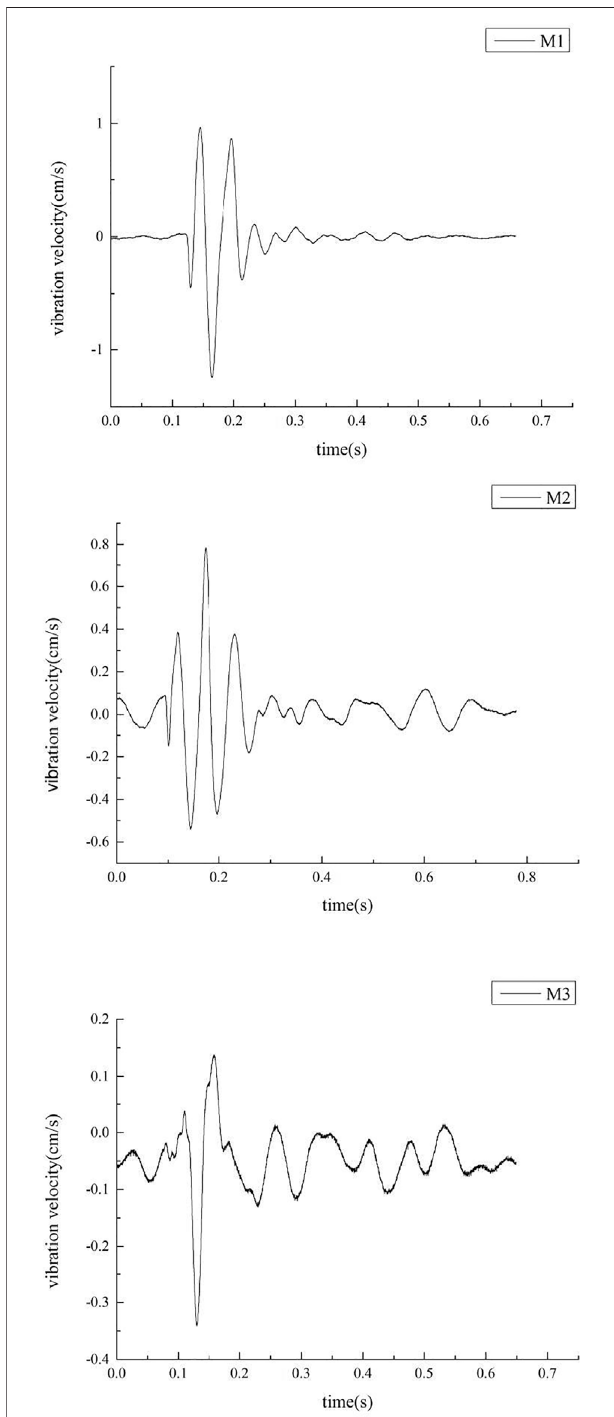
FIGURE 2 | Vibration waveform of single-hole blasting at three measuring